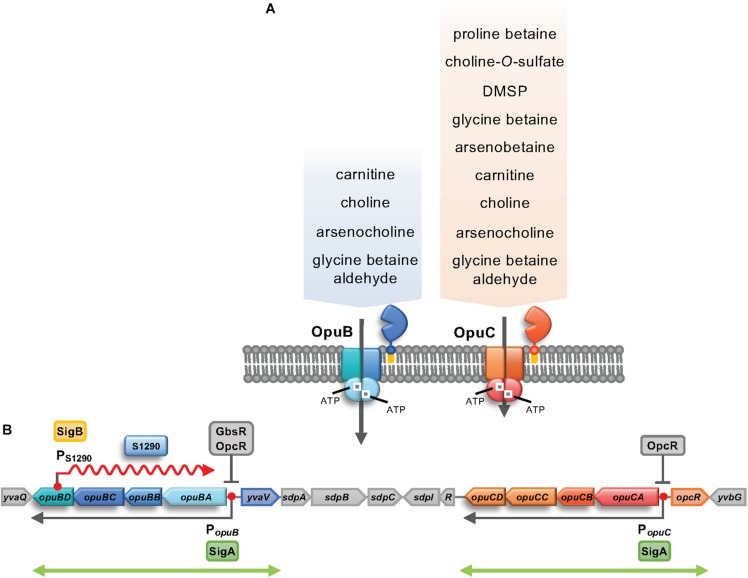
(A) Subunit composition and substrate profile of the OpuB and OpuC ABC transport systems. The OpuB and OpuC transporters consist of a homo-dimeric ATPase (OpuBA/OpuCA), hetero-dimeric trans-membrane components (OpuBB/OpuBD; OpuCB/OpuCD), and an extracellular substrate binding protein (OpuBC/OpuCC) that is tethered to the outer face of the cytoplasmic membrane via a lipid modification at its N-terminus (Kappes et al., 1999; Hoffmann and Bremer, 2017). The entire substrate spectrum of the OpuB system is shown, while only some of the 15 known substrates of the OpuC transporter are indicated (Hoffmann and Bremer, 2017; Teichmann et al., 2018). (B) Genetic organization of the opuB and opuC operons and their flanking regions. The positions of the SigA-dependent opuB and opuC promoters are indicated by red dots and the extent of the coding mRNA of these operons is depicted by arrows (Kappes et al., 1999). opuB expression is controlled by the repressor GbsR (Nau-Wagner et al., 2012) and by OpcR, while opuC expression is just responsive to OpcR (Lee et al., 2013). opcR and yvaV encode GbsR-type transcriptional regulators (Lee et al., 2013; Ronzheimer et al., 2018). The genes between yvaV and opuCD encode components of the B. subtilis cannibalism system and its genetic regulation (Gonzalez-Pastor et al., 2003; Ellermeier et al., 2006). The position of the SigB-dependent promoter in opuBD is given, as is the extent of the resulting S1290 asRNA annotated by Nicolas et al. (2012). The double-headed green arrows depict the duplicated region in the B. subtilis genome (Kunst et al., 1997; Kappes et al., 1999) that led to the evolution of the B. subtilis OpuB and OpuC transport systems (Teichmann et al., 2017).